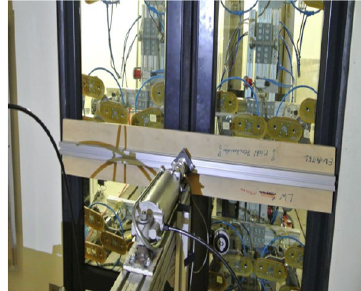
Figure 20. Real loading (static) on the testing table.